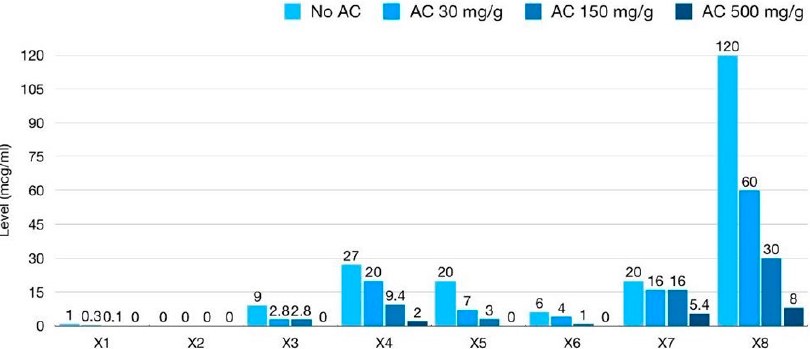
Absolute levels of fecal ceftriaxone (mcg/mL) after AC mixing declined for all patients (Figure 2). The average geometric mean reductions (GMRs) in fecal ceftriaxone concen- trations after AC mixing at different doses, compared to baseline of each Xx sample, are shown in Table 3. Since the 100 × dilution of the baseline X 2 sample was at the borderline of the lower detection limit of the ELISA kit, the effect of AC mixing might be unreliable. In contrast, the raw data of a 2000 × dilution of baseline X 8 were more than the highest detection limit of the ELISA kit, so the effect of AC mixing might be underestimated. There- fore, a sensitivity analysis was performed by excluding these samples, resulting in three datasets: N = 8 (all X 1–8 samples), N = 7 (exclusion of the X 2 sample), and N = 6 (exclusion of X 2 and X 8 ). However, the amount of fecal ceftriaxone adsorbed by AC was consistent at all doses among all data sets with effect sizes and 95%CI of similar magnitudes (Table 3 and Figure 4).